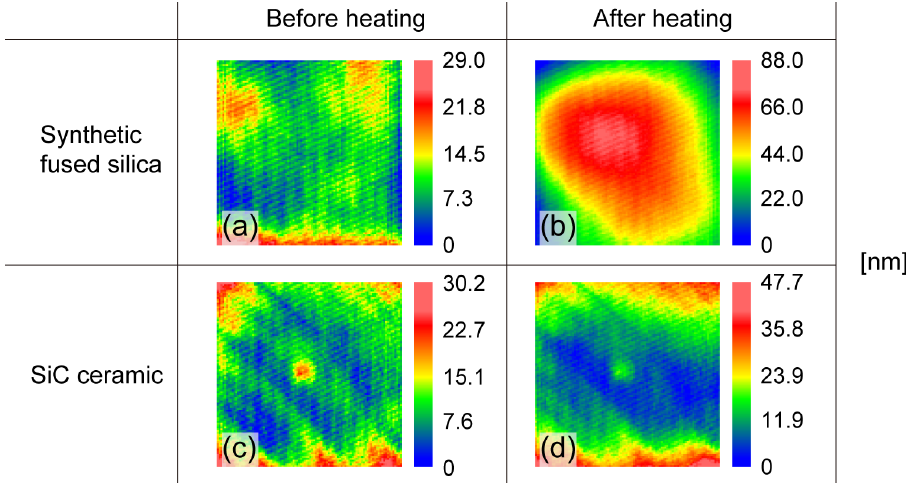
Figure 5. Surface accuracies of gold mirrors measured with the laser interferometer. The color scales are normalized to the maximum in each picture. Surface accuracies of the synthetic fused silica mirror ( a ) before laser irradiation and ( b ) after 20 min laser irradiation. Surface accuracies of the SiC ceramic mirror ( c ) before laser irradiation and ( d ) after 20 min laser irradiation. The values of peak-to-valley surface accuracy (roughness) in ( a ), ( b ), ( c ), and ( d ) are / 21.8 (29.0 nm), / 7.2 (88.0 nm), / 21.0 (30.2 nm), and / 13.3 (47.7 nm), respectively.